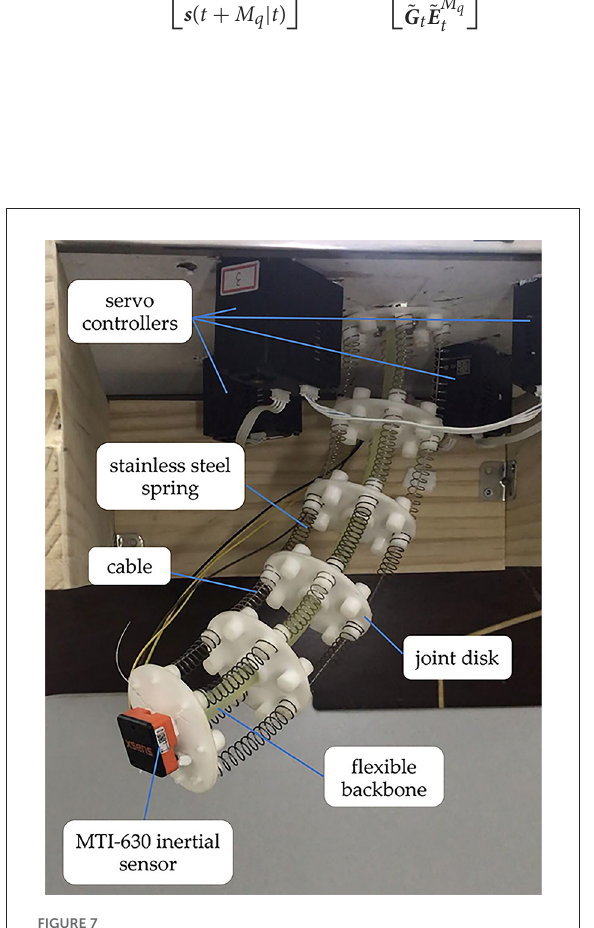
FIGURE7 Experimental platform of the CDCR.